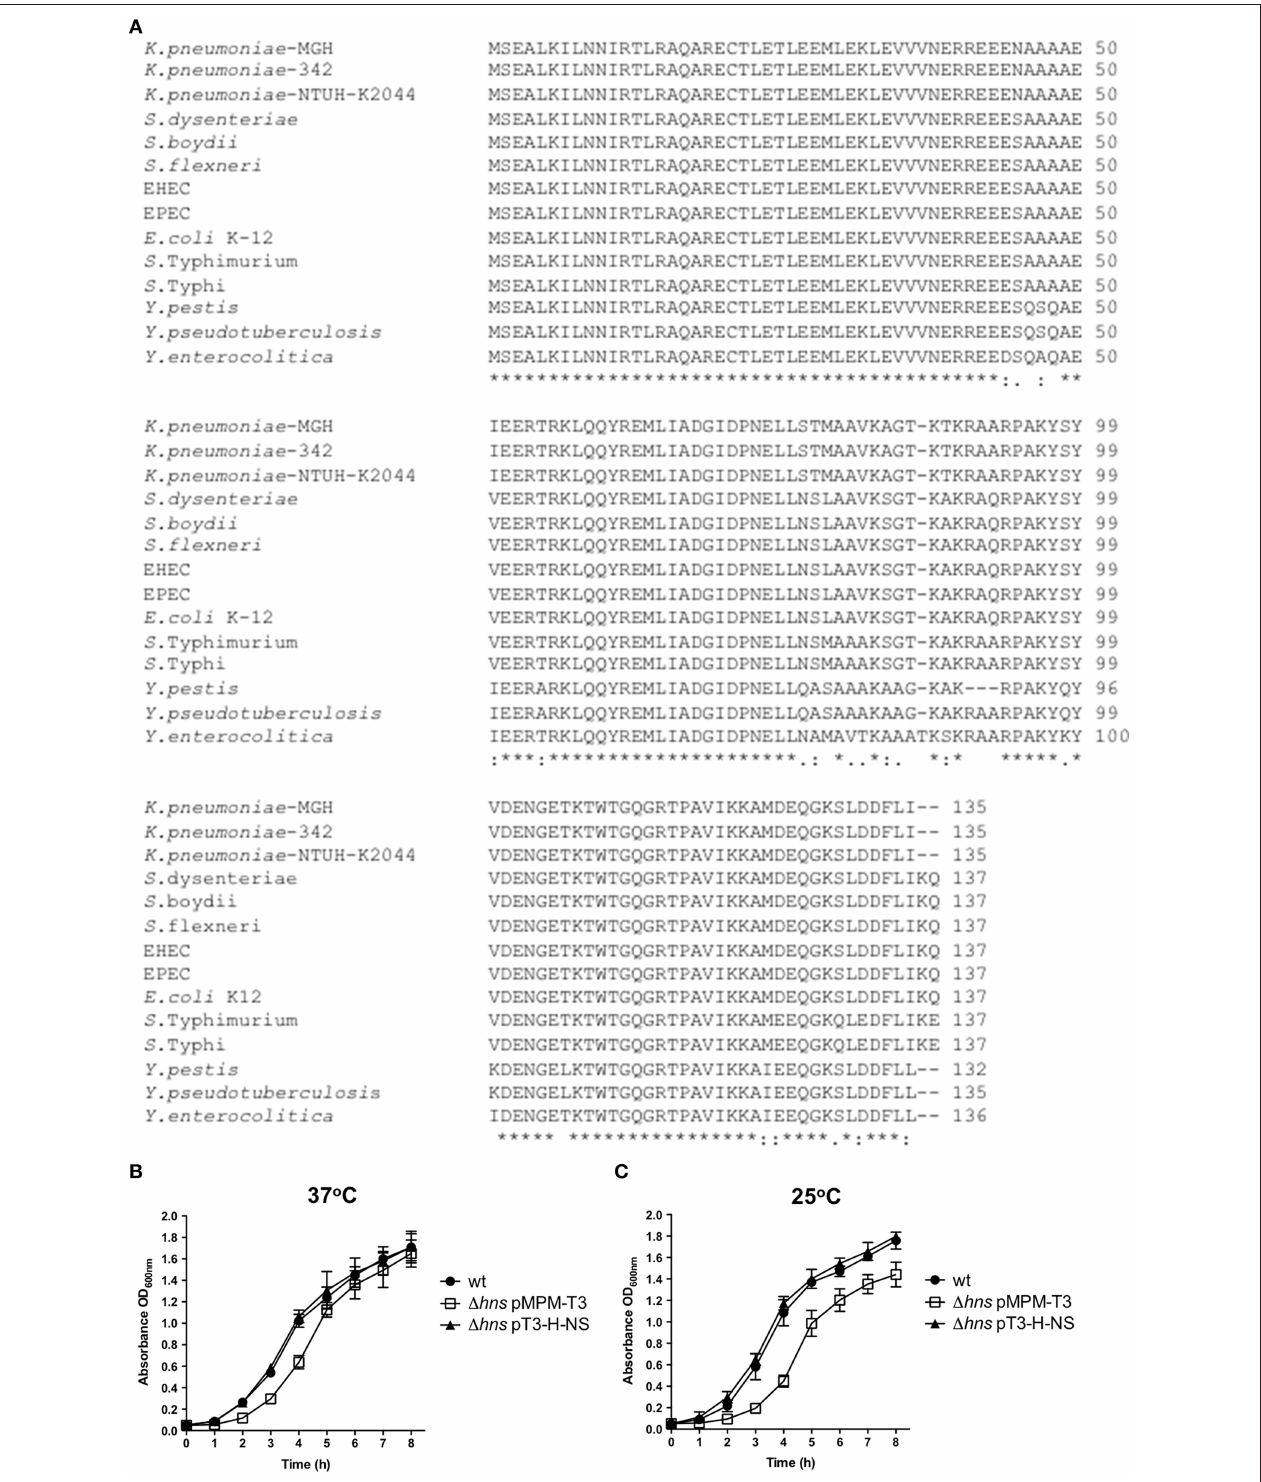
FIGURE 1 | H-NS protein in K. pneumoniae . (A) Alignment of amino acid sequences of H-NS proteins from several enterobacteria: K. pneumoniae (MGH, 342 and NTUH-K2044), Shigella dysenteriae (Sd197), Shigella boydii (Sb227), Shigella flexneri (2a str. 2457T), Enterohemorragic E. coli (EDL933), Enteropathogenic E. coli (E2348/69), E. coli K-12 (MG1655), Salmonella enterica serovar Typhimurium (LT2), Salmonella enterica serovar Typhi (CT18), Yersinia pestis (KIM 10), Yersinia pseudotuberculosis (IP 32953) and Yersinia enterocolitica (8081). Analysis was performed using the ClustalW2 software (http://www.ebi.ac.uk/Tools/msa/clustalw2/). Growth kinetics of wild-type K. pneumoniae , and the isogenic mutants at 37 ◦ C (B) and 25 ◦ C (C) . Bacterial cultures were grown for 8h in LB medium.